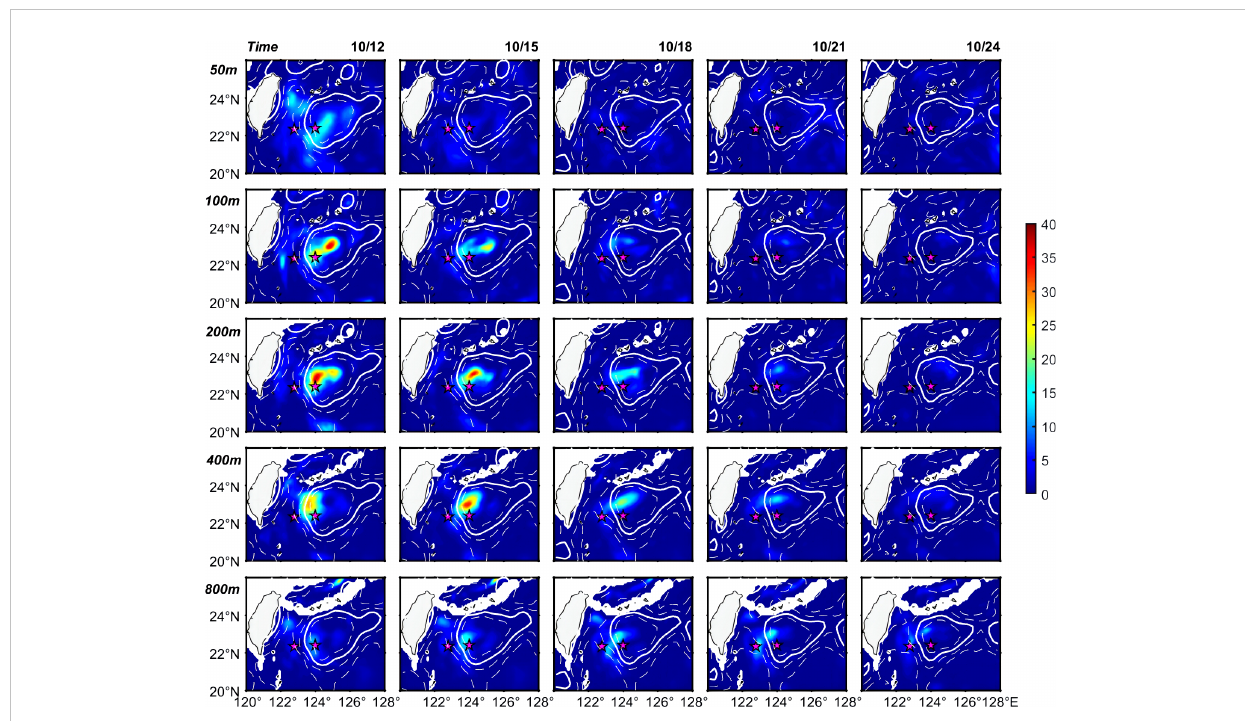
FIGURE 6 Time evolution of NIKE (unit: J/m 3 ) generated by Typhoon MITAG at different depths from 12 to 24 October. All other elements are the same as in Figure 5.